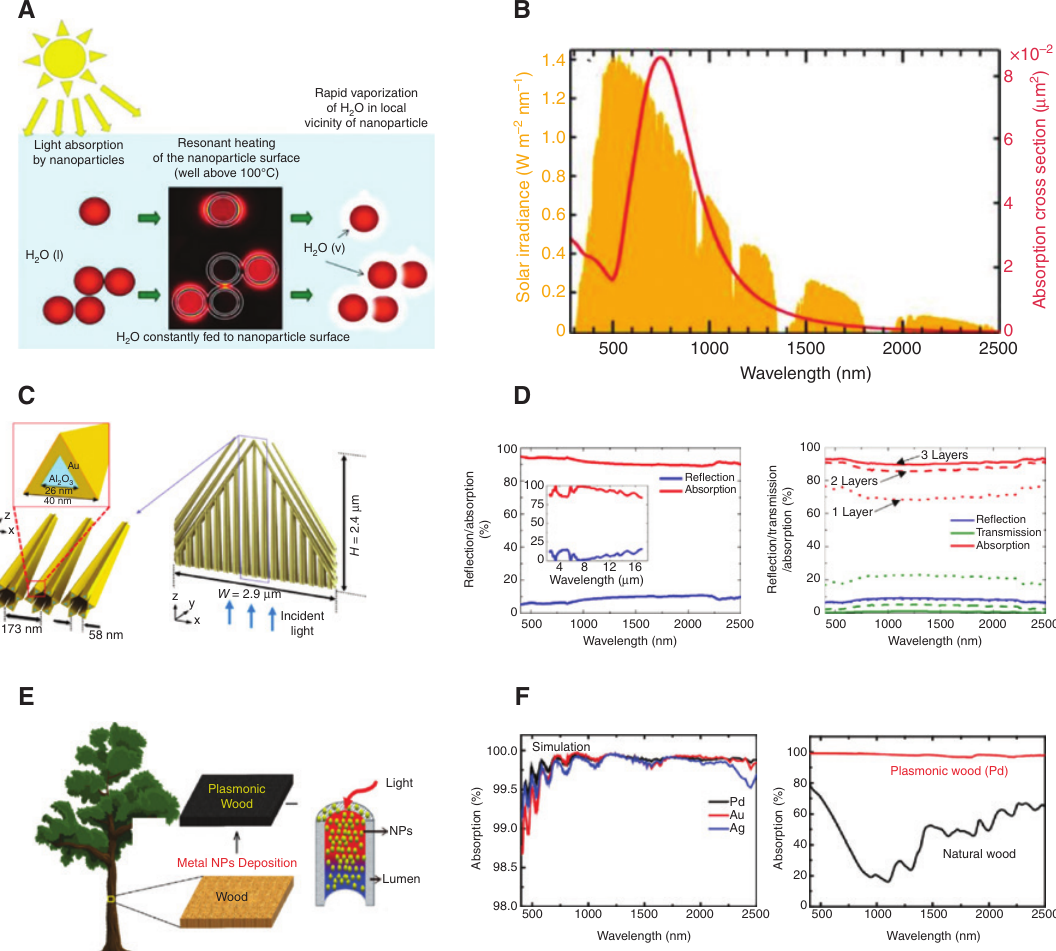
Figure 3: Highly integrated plasmonic structures to achieve high and broadband solar absorption. (A) SiO /Au nanoshells structure and (B) the relative absorption cross section which overlaps the solar spectrum [52]; (C) schematic of flexible 2 thin-film black gold membrane consisting of self-aggregated metallic nanowire bundle arrays and (D) the optical properties of single layer (left) and multilayer membrane (right) [88]; (E) schematic of plasmonic wood and (F) its enhanced absorption performance [59]. (A) and (B) Reprinted with permission from Ref. [52]. Copyright 2013 American Chemical Society. (C) and (D) Reprinted with permission from Ref. [88]. Copyright 2016, Nature Publishing Group. (E) and (F) Reprinted with permission from Ref. [59]. Copyright 2014 American Chemical